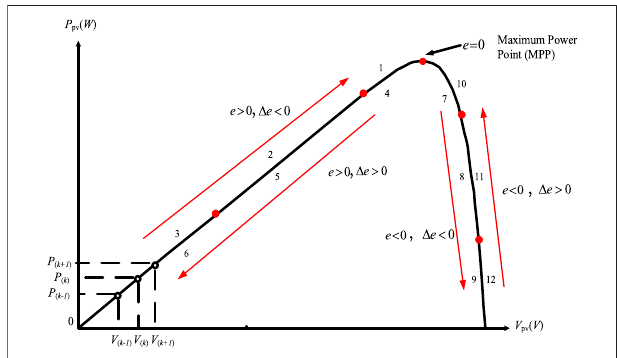
FIGURE 1 | Schematic diagram of the slope error f and slope error change Δ f of the P-V characteristic